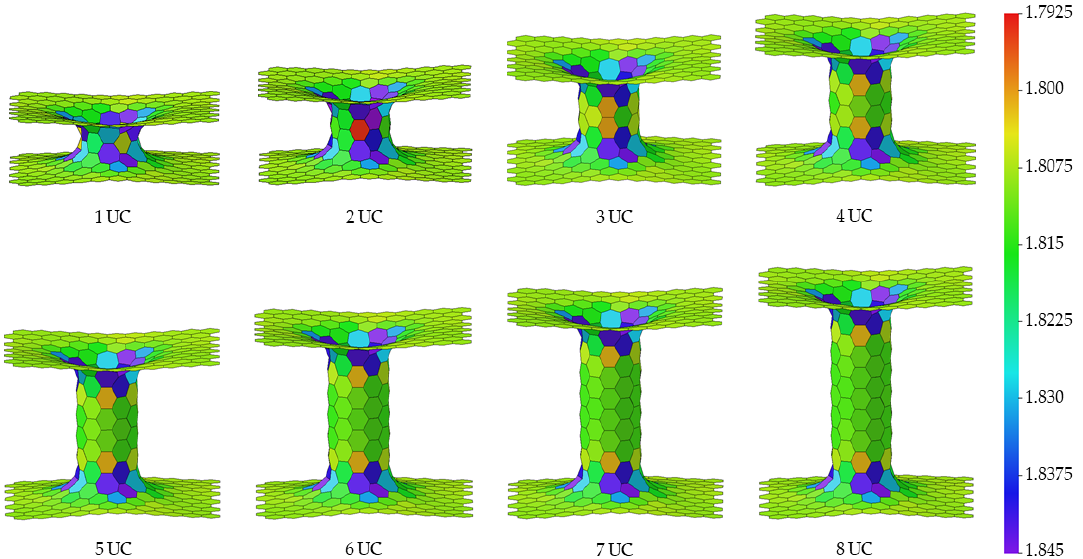
Figure 6. The MBL analysis of the 3D pillared SiC (6,6) nanostructures with various pillar lengths after full geometry optimization.